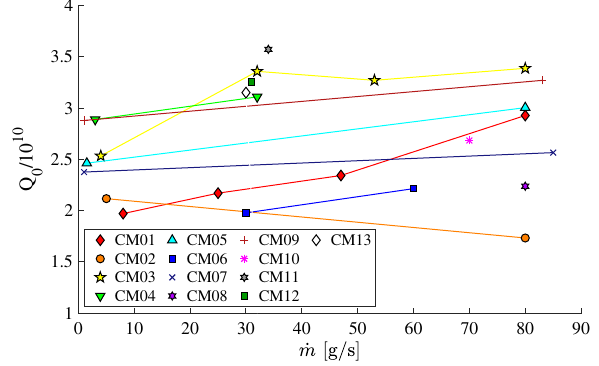
FIG. 9. Cryomodule Q 0 as a function of mass flow of cold helium during cooldown through the critical temperature. In nearly all cases, higher Q 0 is achieved at higher mass flow.